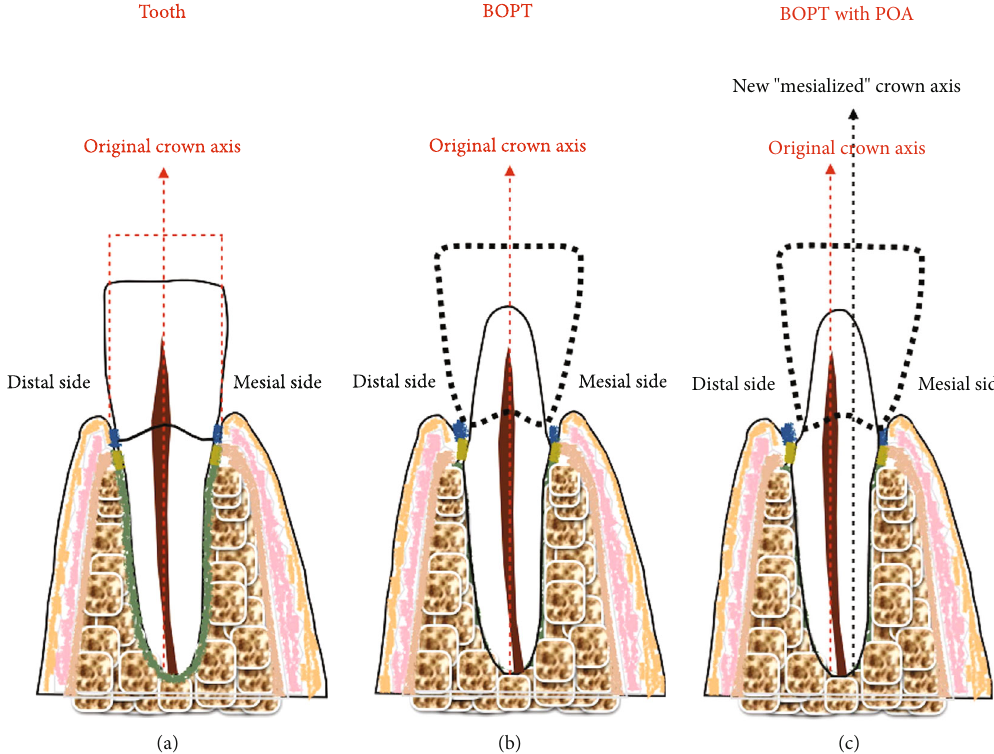
Figure 3: Mesialisation of the abutment tooth using the biologically oriented preparation technique (BOPT): (a) tooth; (b) the tooth is prepared without a fi nish line (BOPT), equally on the distal and mesial sides, such that the tooth axis remains unchanged; (c) the tooth is prepared without a fi nish line (BOPT), more on the distal than on the mesial side: this allows the mesialisation of the crown